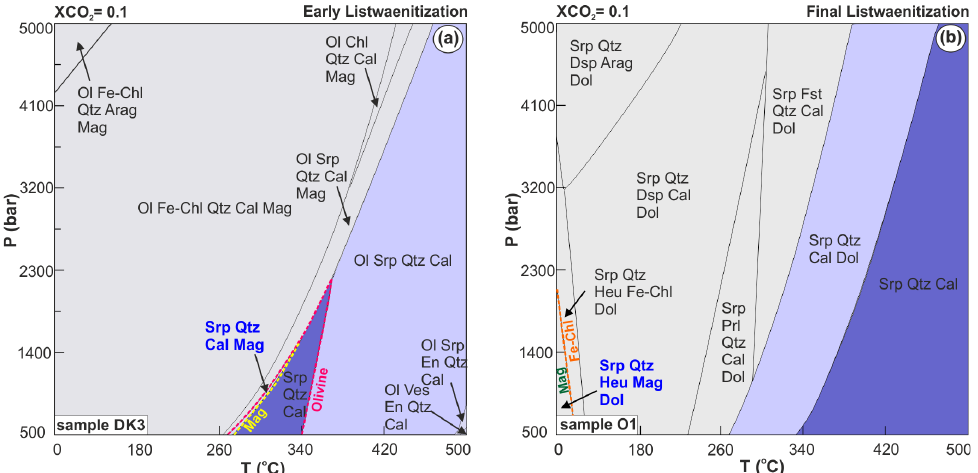
Figure 10. P-T pseudosections on the SFCMAHC (SiO 2 -FeO-CaO-MgO-Al 2 O 3 -H 2 O-CO 2 ) system for the: ( a ) initial listwaenitization stage (proto-listwaenite sample DK3) and ( b ) the final listwaenitization stage (silica-rich listwaenite sample O1).